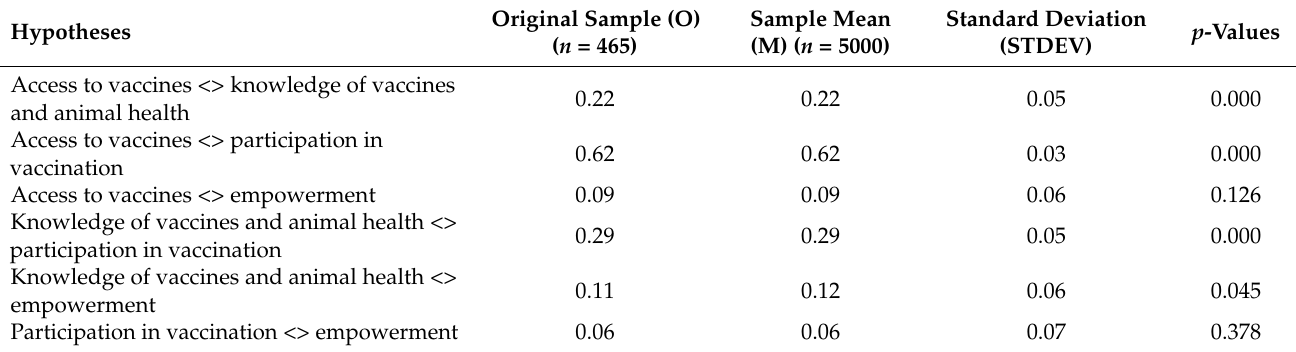
Table 4. Direct relationships (hypothesis) and mediation analysis (standardized path coefficients of latent variables for overall sample) for women.